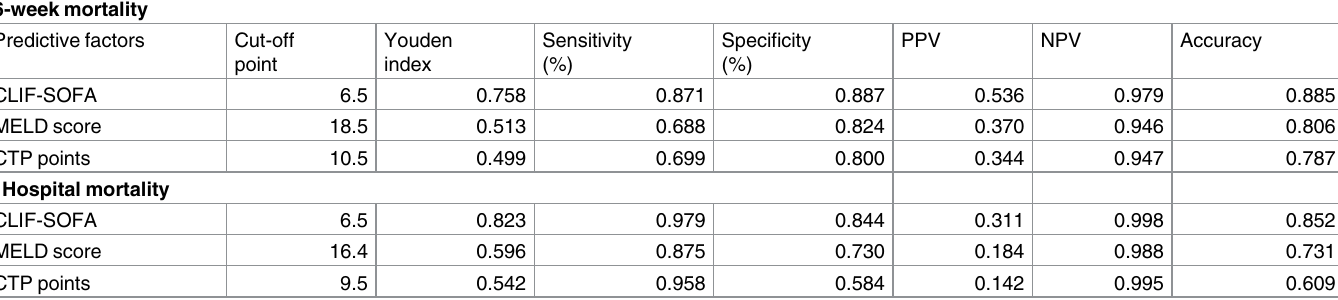
Table 3. Mortality prediction of EVH post